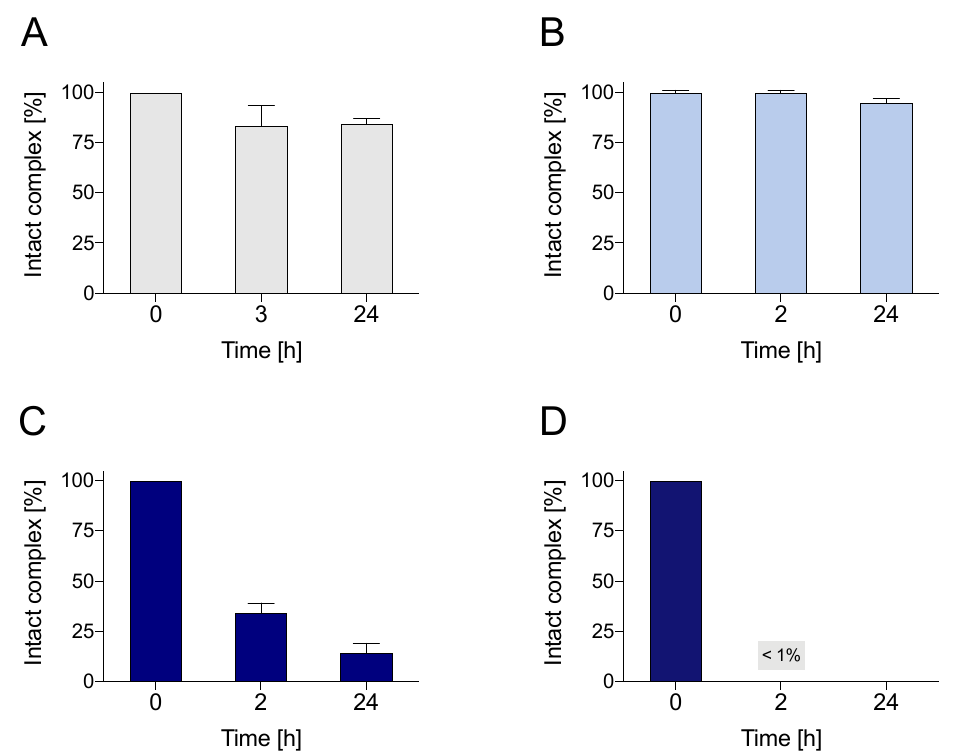
Figure 7. Human serum stability over time of ( A ) [ 64 Cu][Cu(DOTA)] 2 − , ( B ) [ 64 Cu][Cu(DO2A2S)], ( C ) [ 64 Cu][Cu(DO4S)] 2+ and ( D ) [ 64 Cu][Cu(TRI4S)] 2+ .